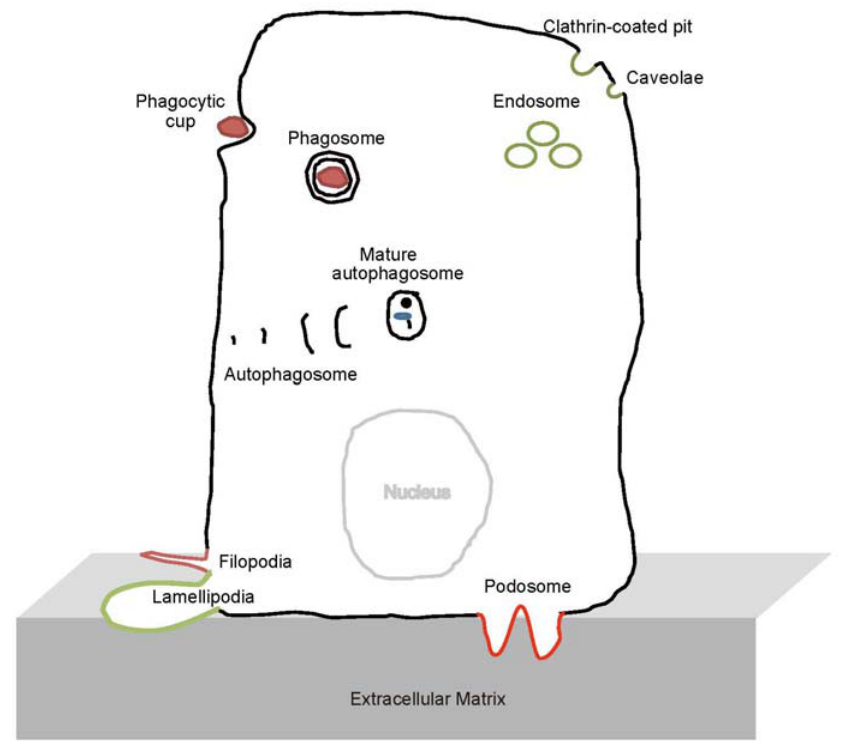
Figure 1. Subcellular structures on which Bin-Amphiphysin-Rvs167 (BAR) domain proteins act, as discussed in this